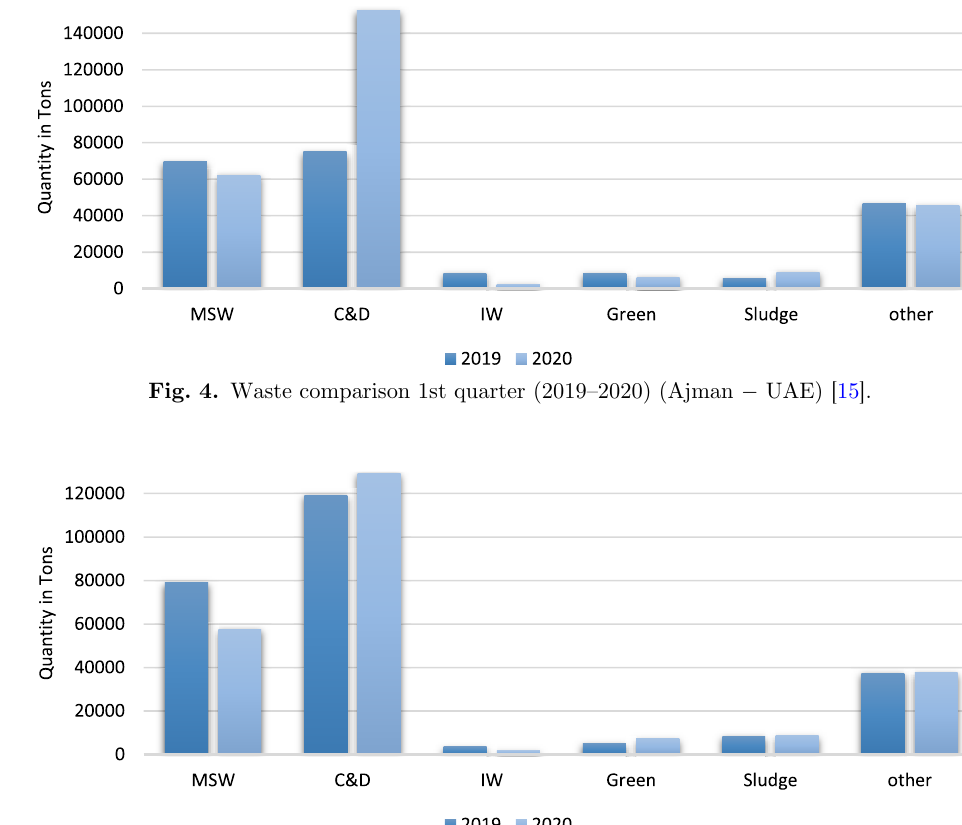
Fig. 5. Waste comparison 2nd quarter (2019 – 2020) (Ajman (cid:1) UAE) [15].